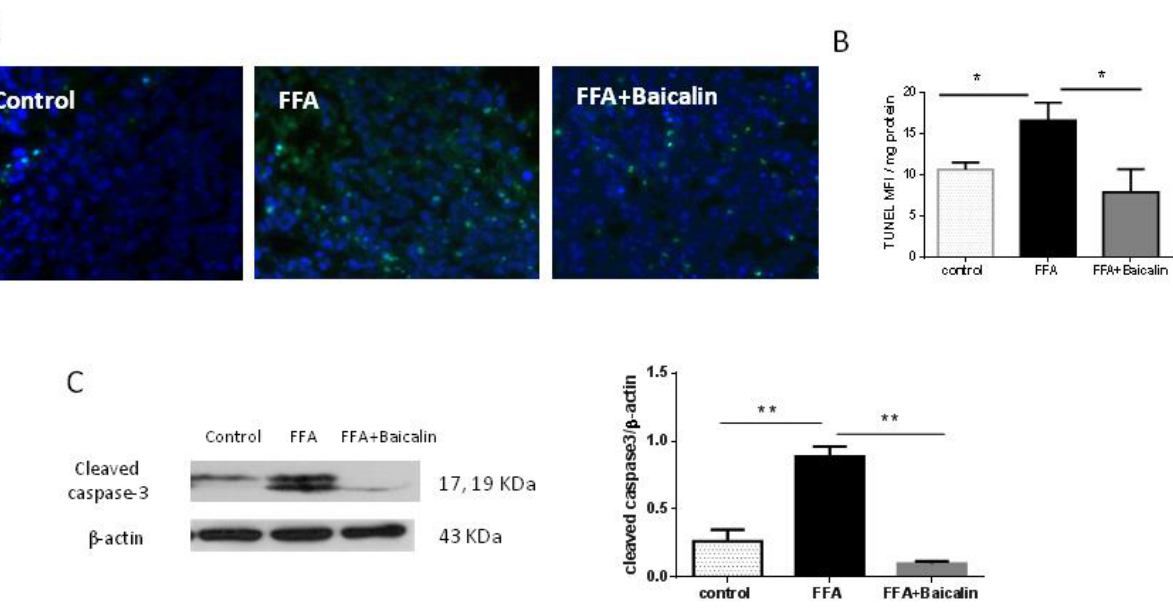
Figure 5. Baicalin decreases FFA-induced apoptosis. ( A ) TUNEL staining. TUNEL, green; DAPI, blue. ( B ) Quantitative analysis of TUNEL data; results were presented as MFI ( n = 5). ( C ) Expression of cleaved caspase-3 among the three groups, assessed by Western blot. Immunoreactive bands are shown on the left, and quantitation is shown on the right ( n = 5). * p < 0.05; ** p < 0.01.